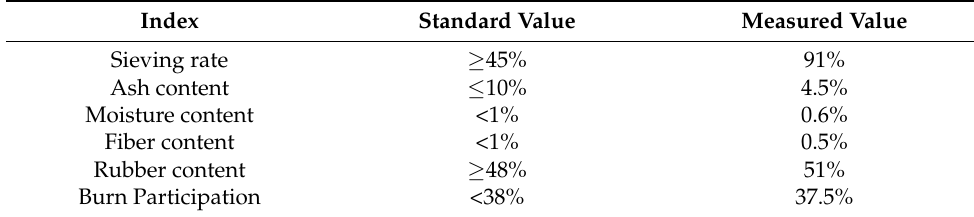
Table 2. Technical indices of CR.